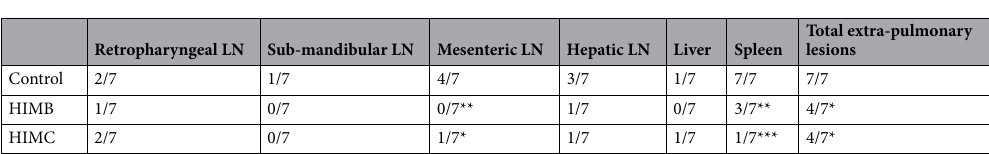
Table 2. Number of animals with extrapulmonary TB lesions and their location in each treatment group (N = 7). * P < 0.05, ** P < 0.01, *** P < 0.001, Chi-square test.